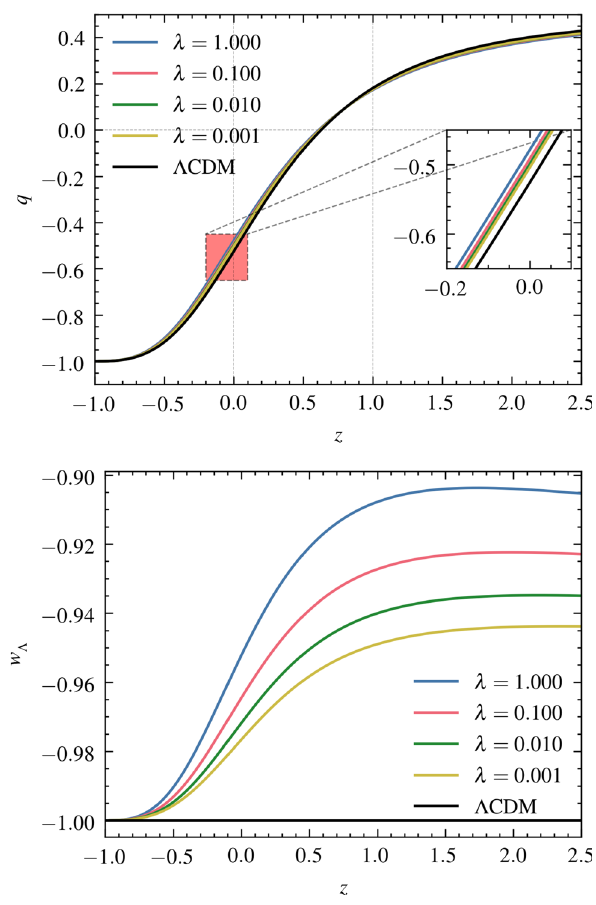
Fig. 8 Deceleration parameter ( q ) and dark energy equation of state parameter ( w (cid:2) ) as a function of redshift ( z ) for different values of λ (with (cid:12)